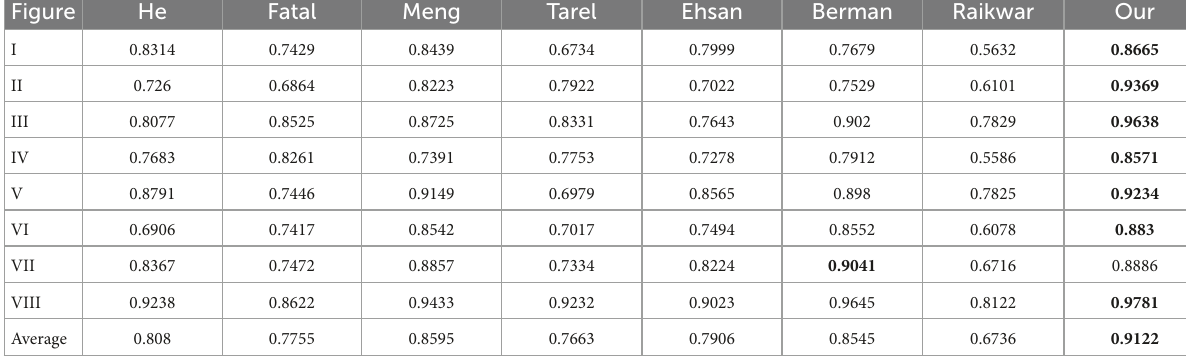
TABLE 5 Comparison of universal quality index (UQI) of the defogging images.